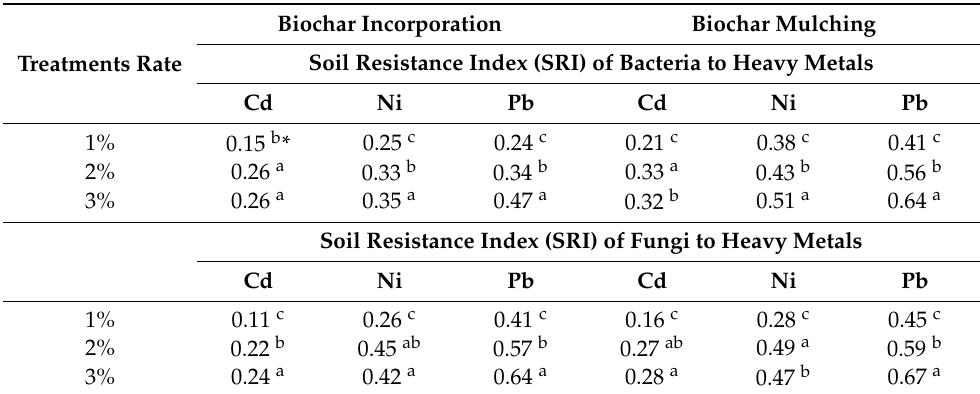
Table 11. Soil Resistance Index (SRI) of bacteria and fungi to Cd, Ni, and Pb concentrations in drainage water for the irrigation of biochar-amended sandy